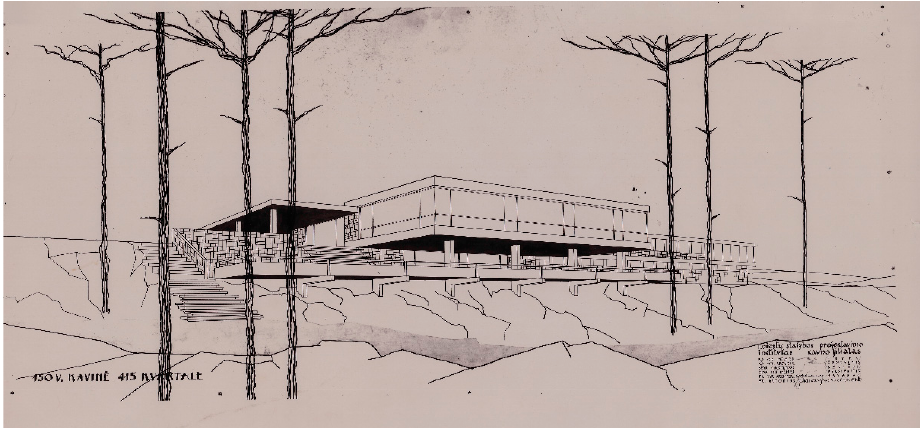
Figure 3. The design of the restaurant “Trys mergel ė s” in Kaunas, designed in 1965 by A. and V. Jaku č i ū nai. From the personal archive of V. Jaku č i ū nien ė .